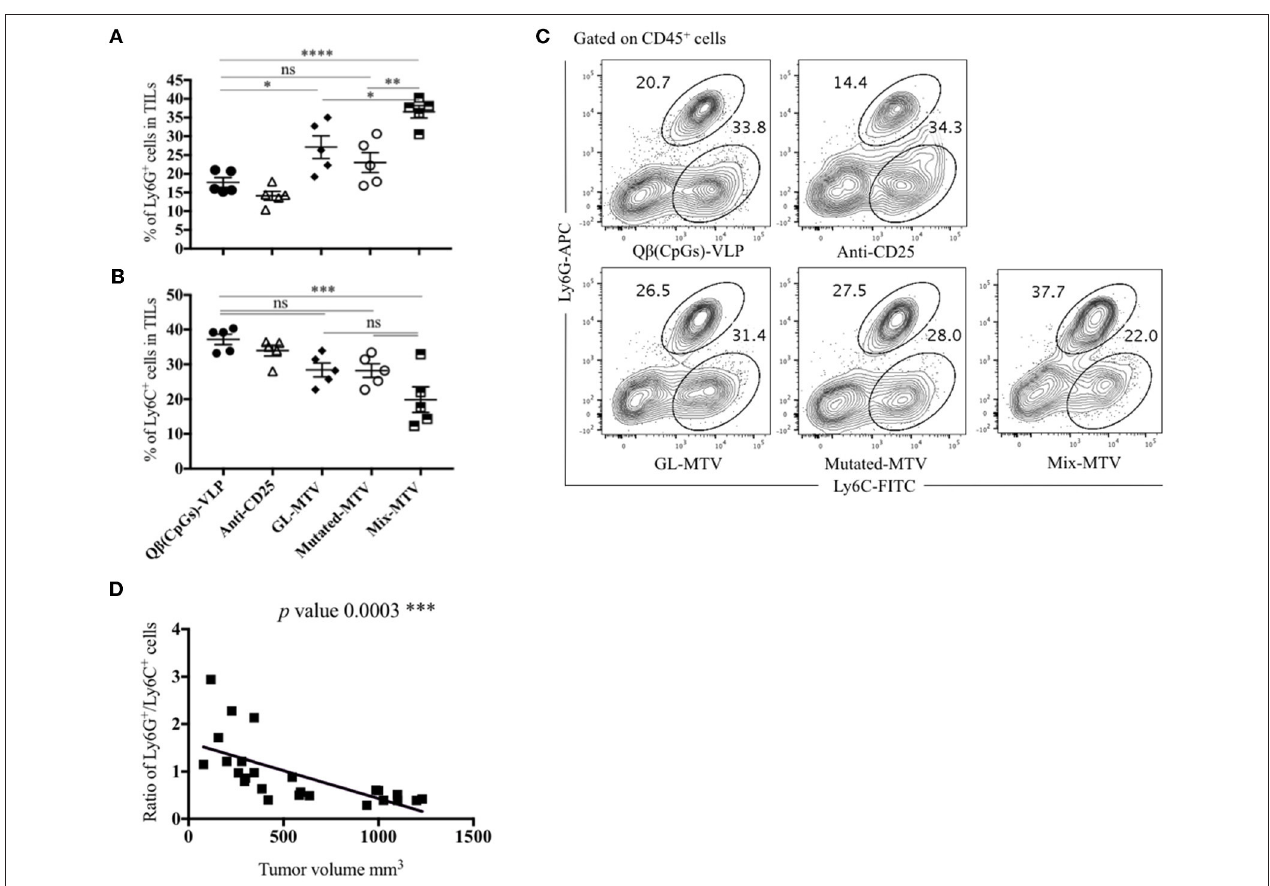
FIGURE 7 | Mix multi-target vaccine altered the myeloid composition of B16F10 tumor. (A) Percentage of Ly6G + cells (means ± SEM) in TILs, pre-gated on CD45 + cells in the groups vaccinated with Q β (CpGs)-VLPs, anti-CD25, GL-MTV, Mutated-MTV, and Mix-MTV. (B) Percentage of Ly6C + cells (means ± SEM) in TILs, pre-gated on CD45 + cells in the vaccinated groups. Statistical analysis by one-way ANOVA. (C) Representative FACS plots showing the percentage of Ly6G + and Ly6C + cells in TILs in the vaccinated groups. (D) Correlation between the ratio of the percentage of Ly6G + and Ly6C + cells over the tumor volume mm 3 in the vaccinated groups. Statistical analysis by linear regression. The groups of GL-MTV, Mutated-MTV, and Mix-MTL were combined with anti-CD25mAb in all experiments. ( n = 5) mice per group, one representative of 3 similar experiments is shown. * P < 0.05 ; ** P < 0.01 ; *** P < 0.001 ; **** P <